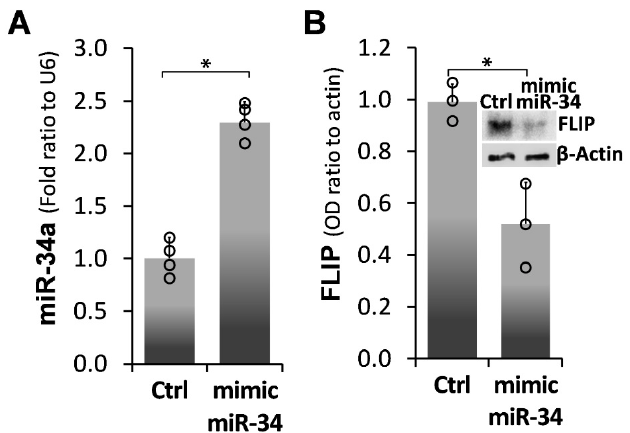
Figure 1. Human idiopathic pulmonary fibrosis (IPF) primary lung-myofibroblasts, compared to normal-, primary-lung myofibroblasts, decrease miR-34a levels and show an inverse correlation with FLICE-like inhibitory protein (FLIP) expression ( A ) Graphical presentation of FLIP protein expression determined by optical densities (OD) in Western blot (WB), and ( B ) qPCR miR-34a expression levels (calculated as 2 − ∆∆ Ct ) in normal (NL) vs. fibrotic (IPF) lung myofibroblasts. n = 5–6. ( C ) qPCR for miR-34b and ( D ) miR-34c in NL and IPF human lung myofibroblasts. Error bars represent mean ± SD; circles represent individual data points. * p < 0.01.